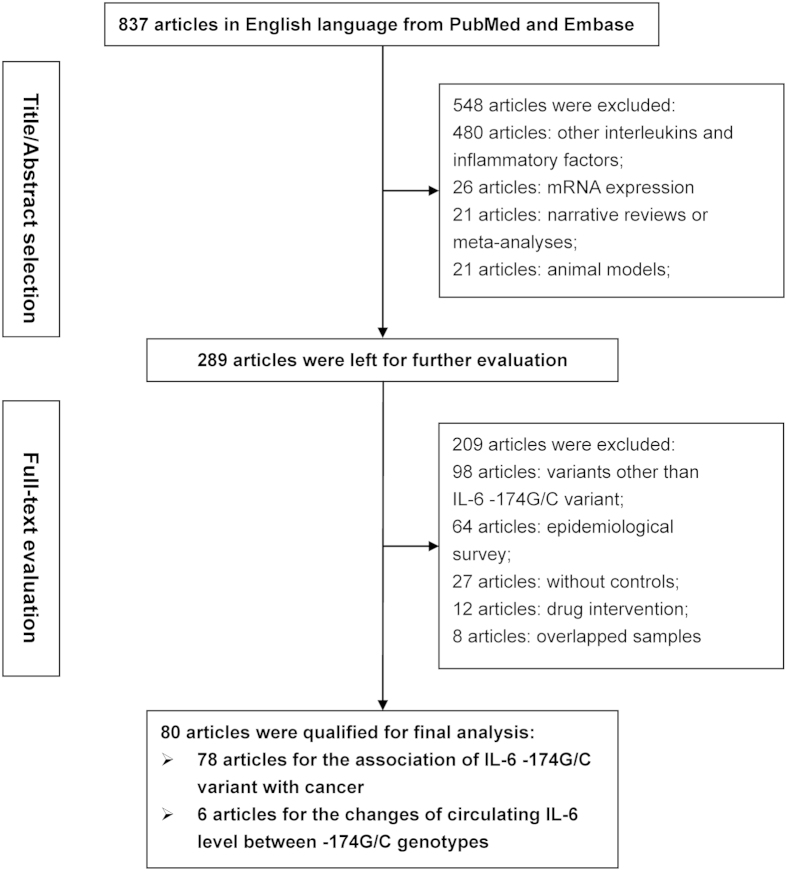
Flow diagram of search strategy and study selection.